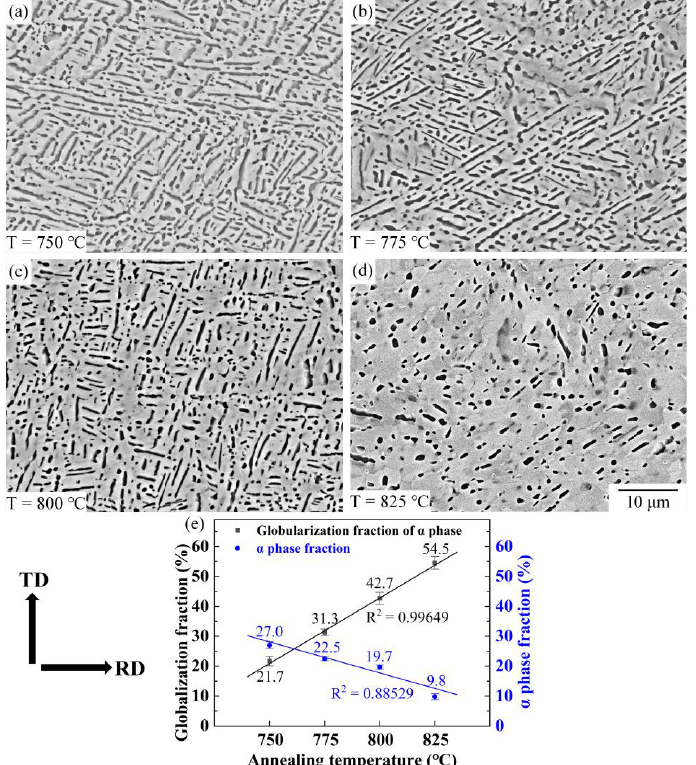
Figure 8. Microstructure of Ti-55511 alloy deformed to a strain of 0.83 and annealed at different annealing temperatures for 30 min: ( a ) 750 °C, ( b ) 775 °C, ( c ) 800 °C, ( d ) 825 °C; ( e ) the fraction and globularization fraction of α phase .